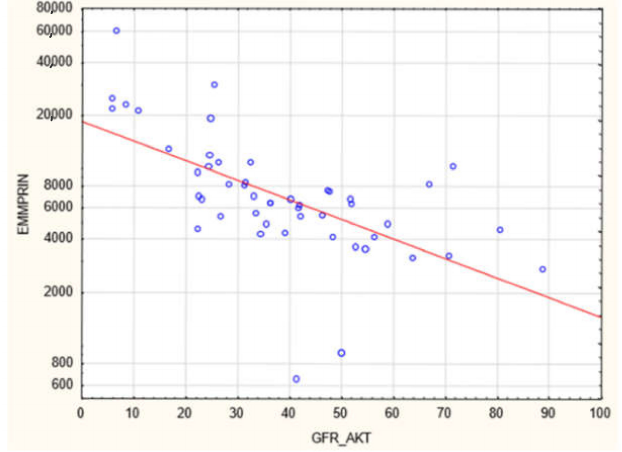
Figure 1. Negative correlation (R = − 0.69, p < 0.05) between EMMPRIN/CD147 concentration and eGFR at the most recent appointment (ME 69 months).